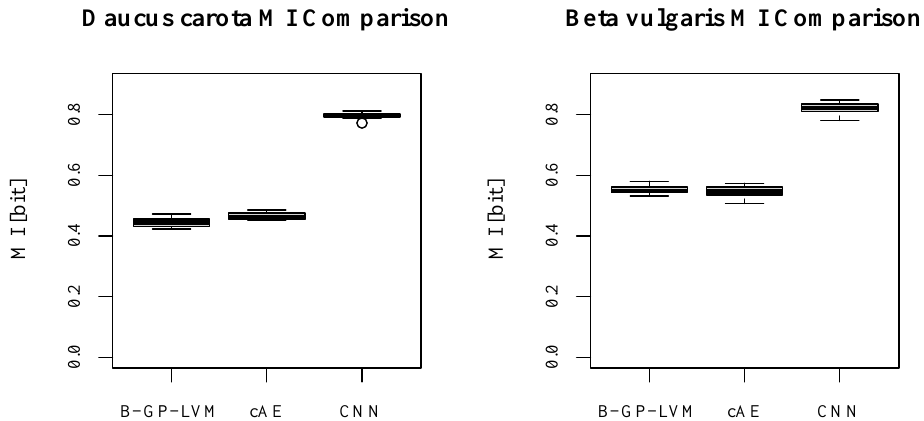
Figure 7. Mutual information of the performed experiments. For both data sets, the CNN outperforms the proposed